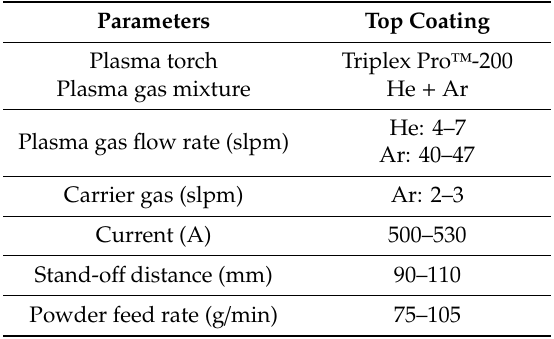
Figure 1. SEM images of spherical yttria-stabilized zirconia (YSZ) powders (Metco 204F feedstock) for the ceramic top-coat. Table 1. The spraying parameters applied to the YSZ coating.